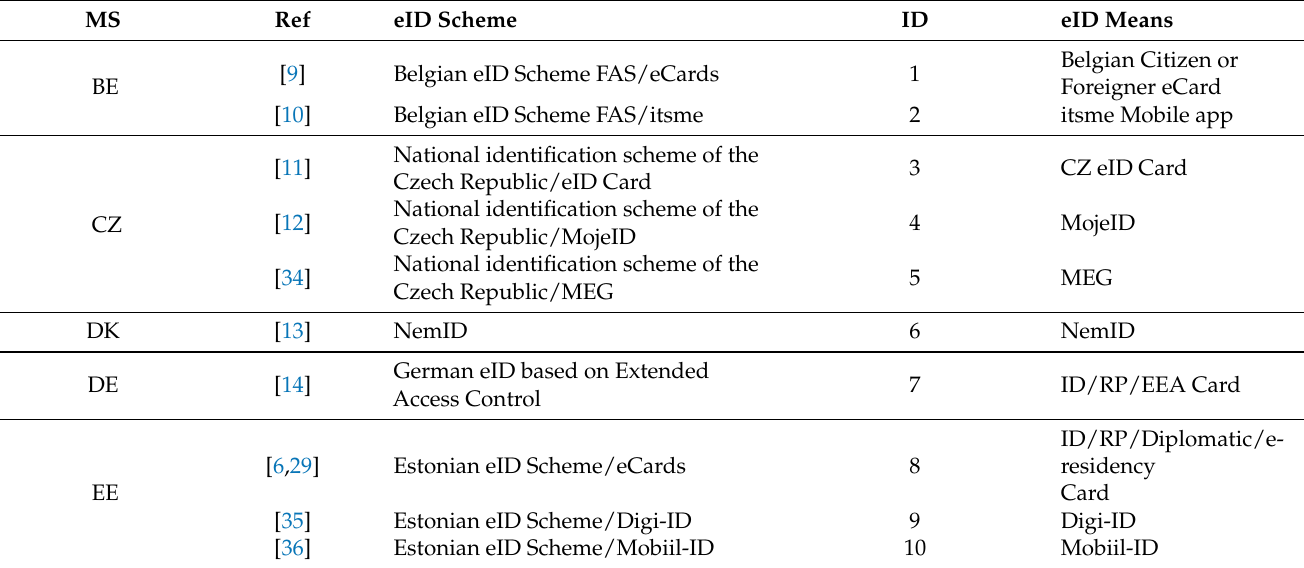
Table 1. List of eID schemes and